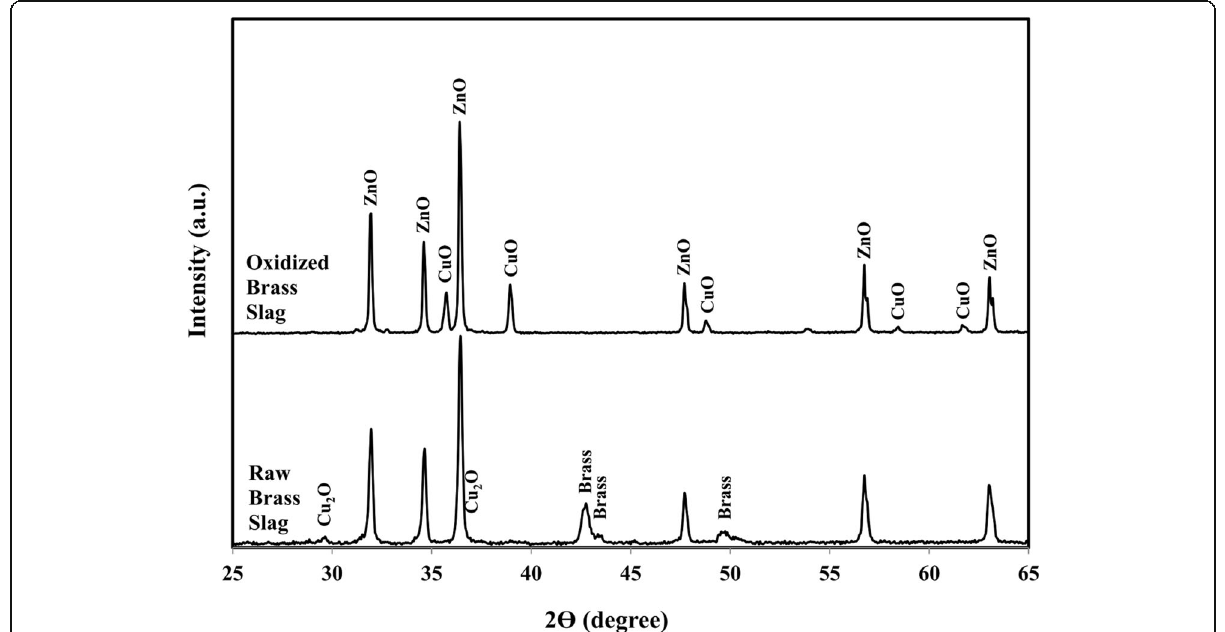
Fig. 3 XRD pattern of raw brass slag and oxidized brass slag (Oxidation in the air at 850 °C for 3